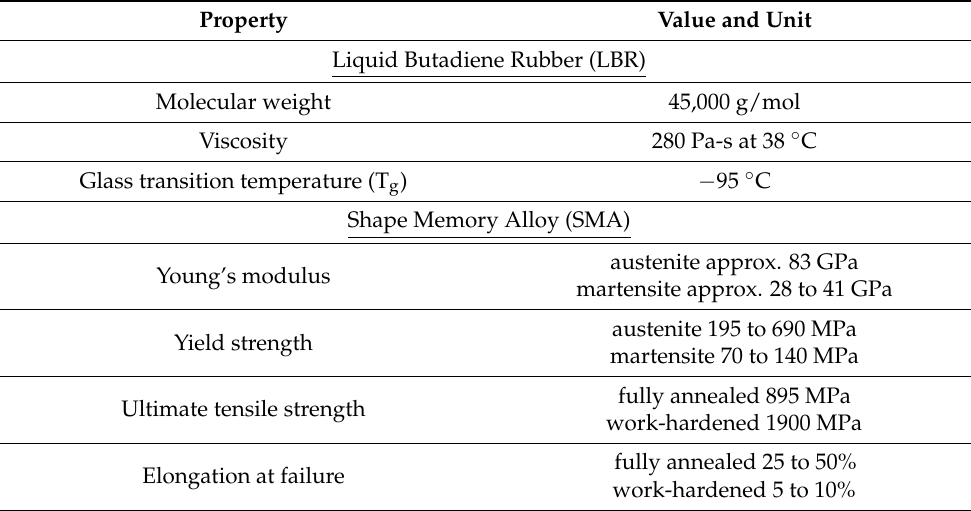
Table 1. Properties of the liquid polybutadiene rubber (LBR 300) and shape memory alloy wire